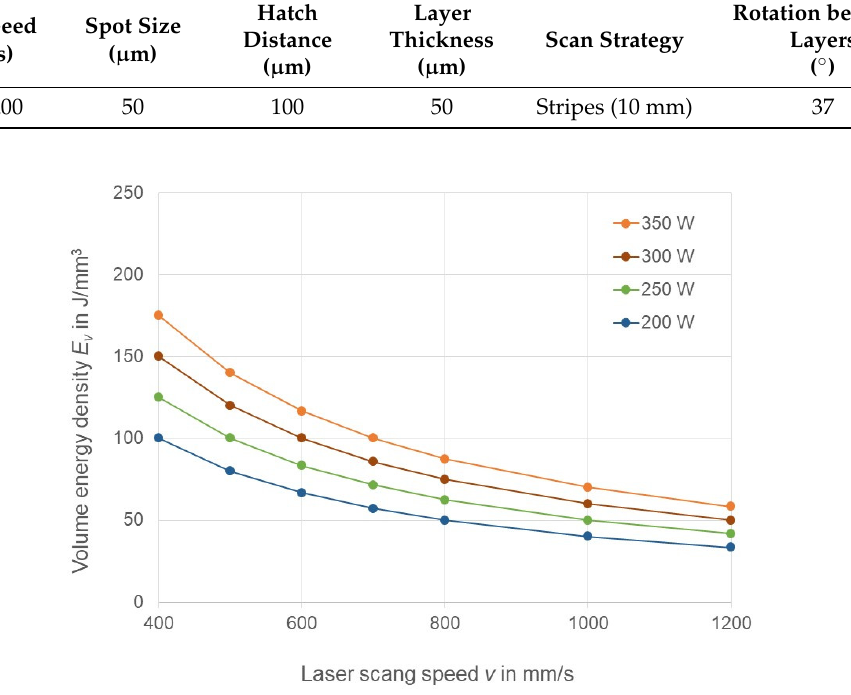
Table 2. PBF-LB process parameters. Table 2. PBF ‐ LB process parameters.